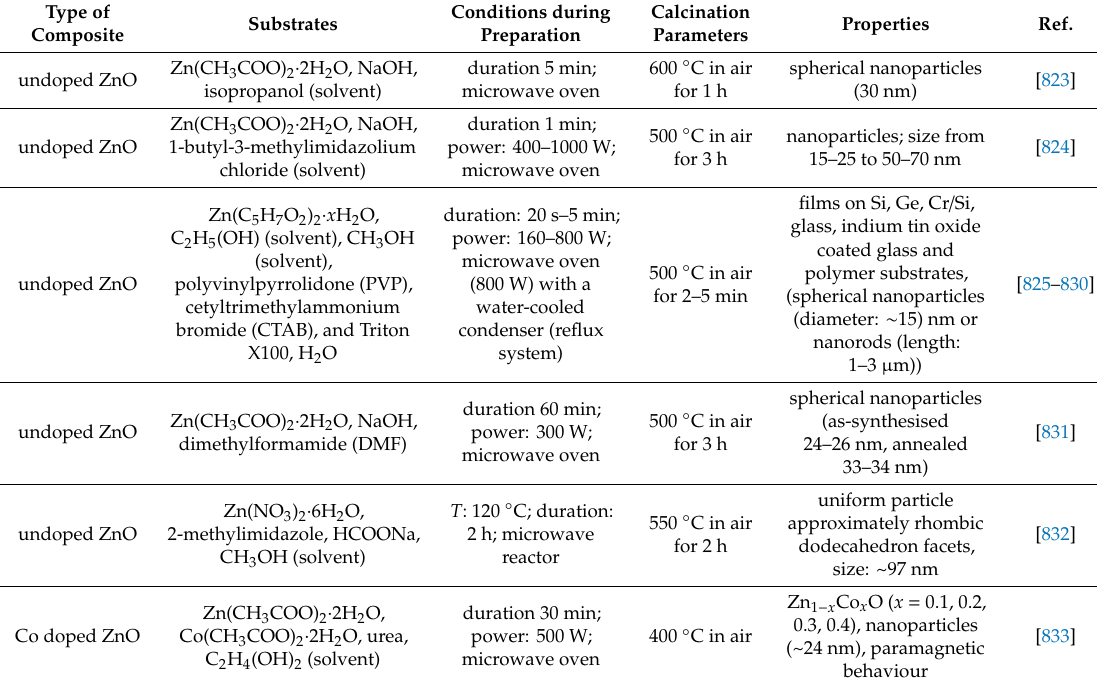
Table 12. Summary of the microwave solvothermal synthesis of ZnO nanocomposites or ZnO hybrid nanostructures with additional heat treatment.